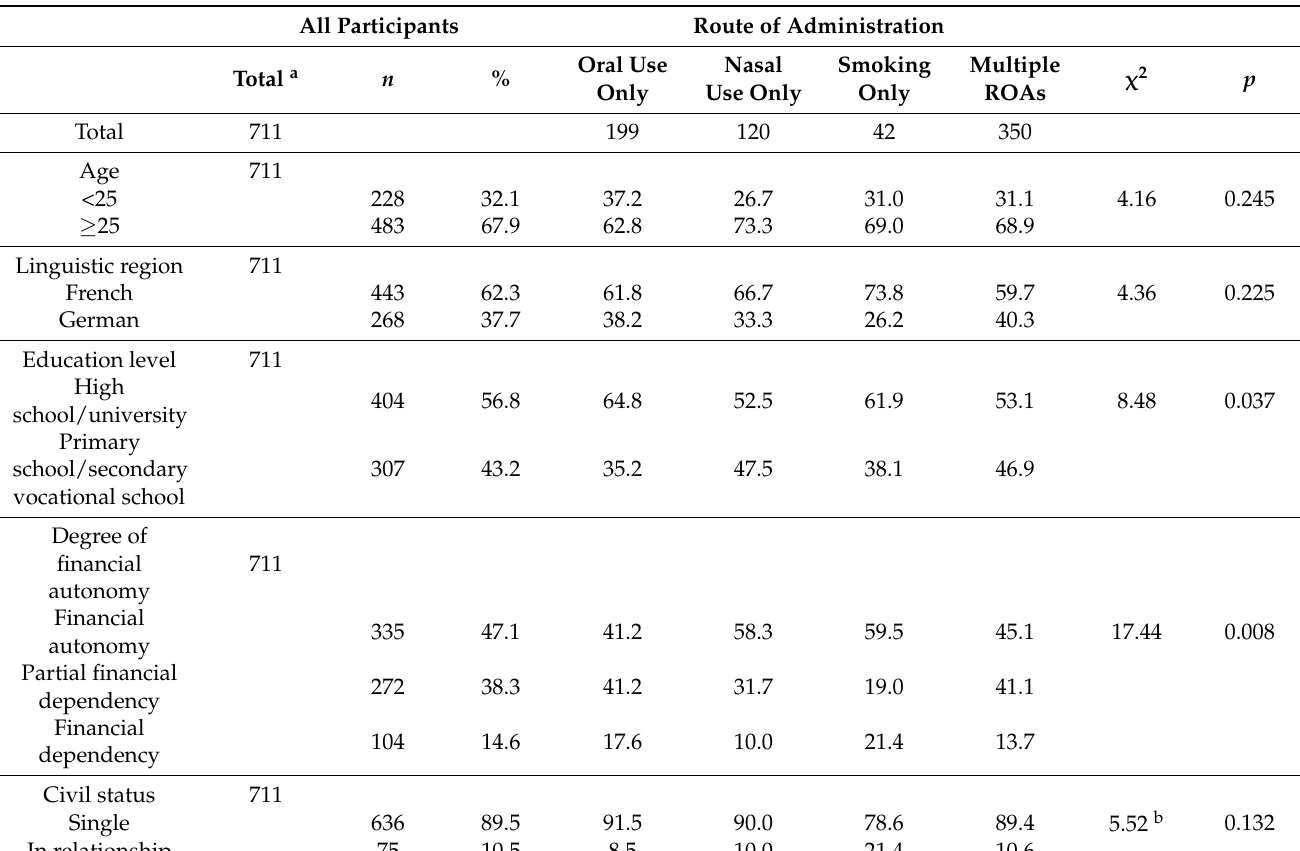
Table 3. Socio-demographic characteristics according to routes of administration among users of any of the 18 illicit drugs. All Participants Route of